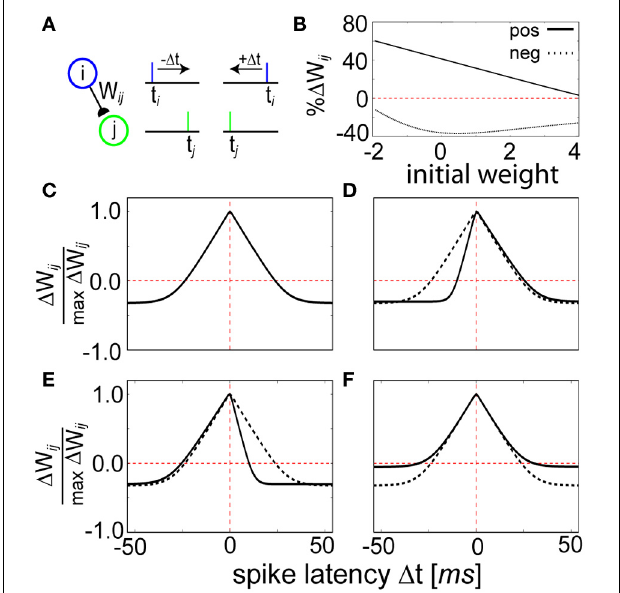
FIGURE 5 | STDP function curves are shaped by the Z trace time constants. (A) Schematic representation of the STDP conditioning protocol. Each pre (blue)—post (green) pairing is repeated for each time difference (cid:12) t = t 1 − t 2 illustrated in (C–E) . (B) Weight dependence for positive ( (cid:12) t = 0ms, solid line) and negative ( (cid:12) t = 50ms, dashed line) spike timings. Compare to Figure 5 of Bi and Poo (1998). (C) Relative change in peak synaptic amplitude using τ zi = 5ms, τ zj = 5ms, τ e = 100ms, and τ p = 10000ms. This curve is reproduced in (D–F) using dotted lines as a reference. (D) The width of the LTP window is determined by the magnitude of the Z trace time constants. When τ zj is changed to 2ms, the coincident learning window shifts right. (E) Instead when τ zi is changed to 2ms, it shifts left. Note that a decrease in τ zi is thus qualitatively consistent with the canonical STDP kernel. (F) Changing the P trace time constant influences the amount of LTD. When τ p is doubled to 20,000ms, the learned correlations tend to decay at a slower